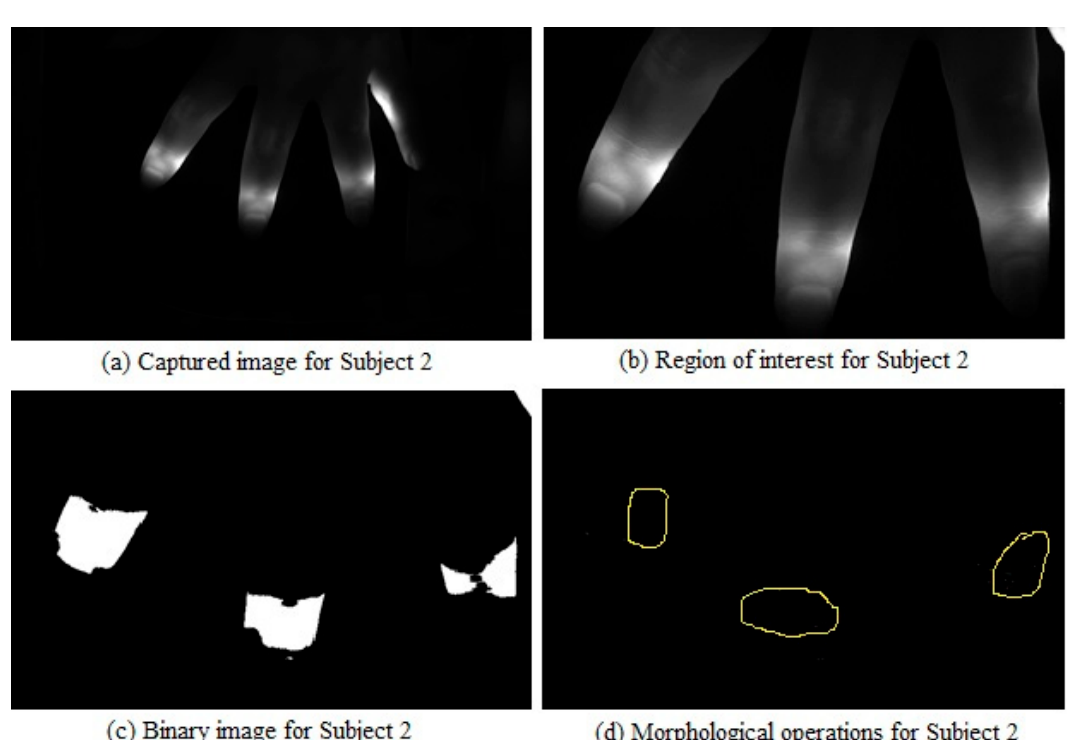
Figure 4. Images for Subject 2.